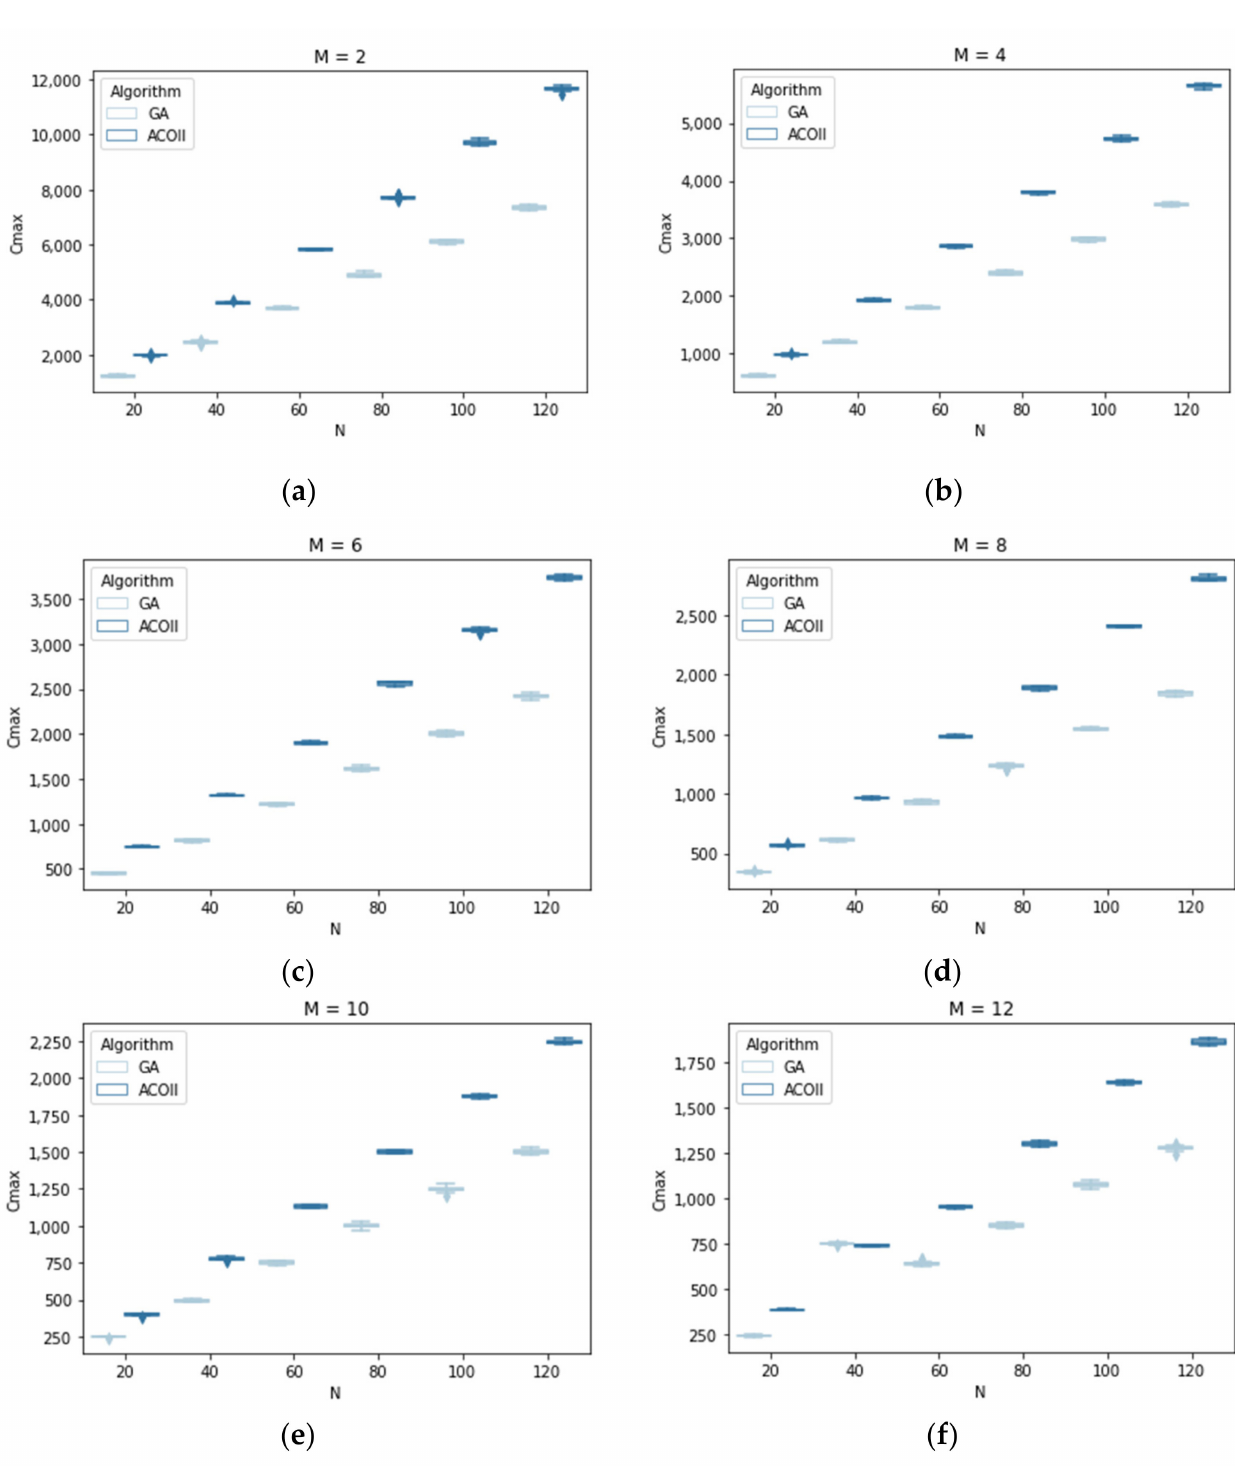
Figure 3. Makespan boxplot for Dominant S large problems for ( a ) M = 2; ( b ) M = 4; ( c ) M = 6; ( d ) M = 8; ( e ) M = 10; ( f ) M =